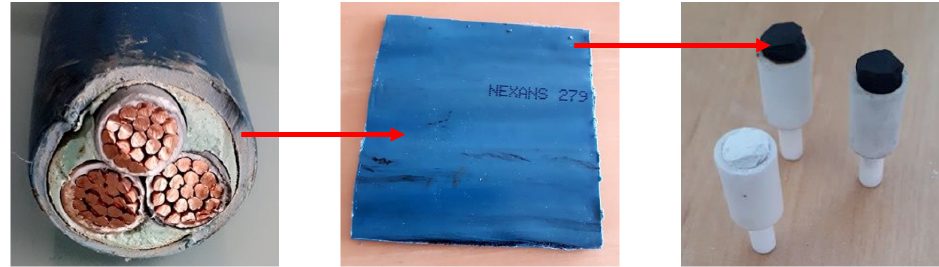
Figure 1. Sample preparation. The black samples in the right picture correspond to state [S1] and the white one to state [S2]. Note the intumescence in the degraded states (the samples in their initial states fitted in the